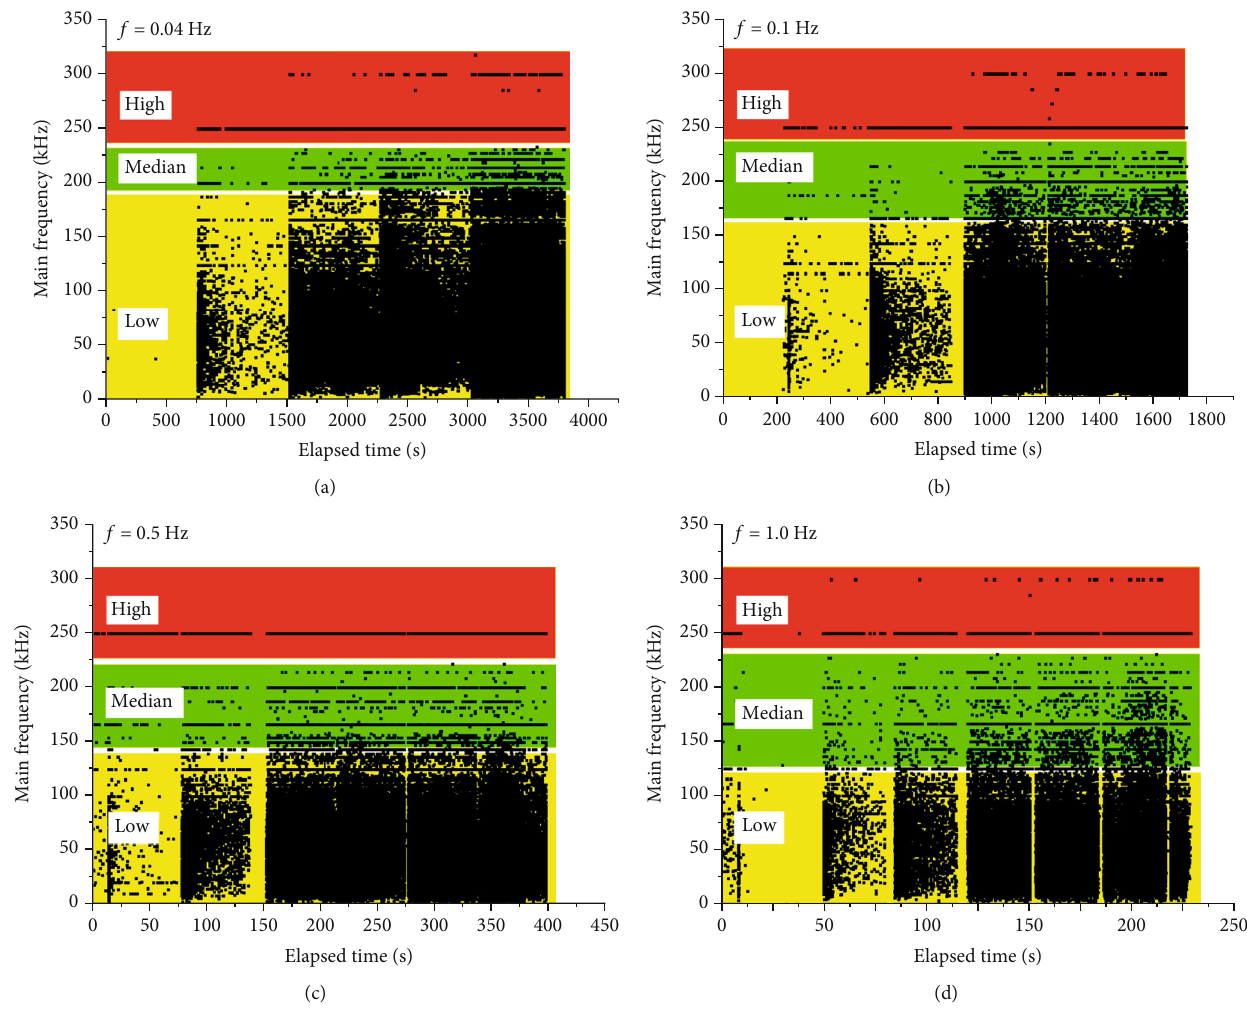
Figure 7: The main frequency characteristics of the tested samples during fracturing. (a – d) The dynamic loading frequency is 0.04, 0.1, 0.5, and 1.0, respectively. Table 2: Main frequency distribution range for the tested samples with di ff erent dynamic loading